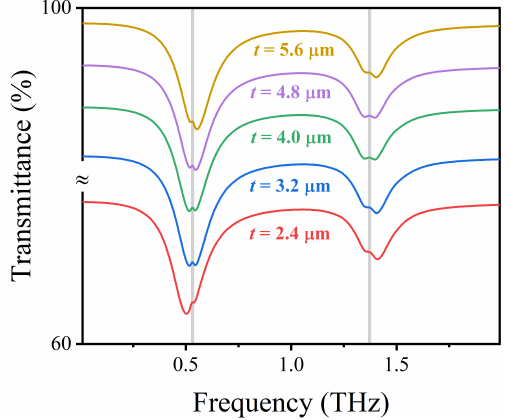
Figure 6. Transmission spectra of AIGS covered with lactose at different substrate thicknesses t under vertically incident TM